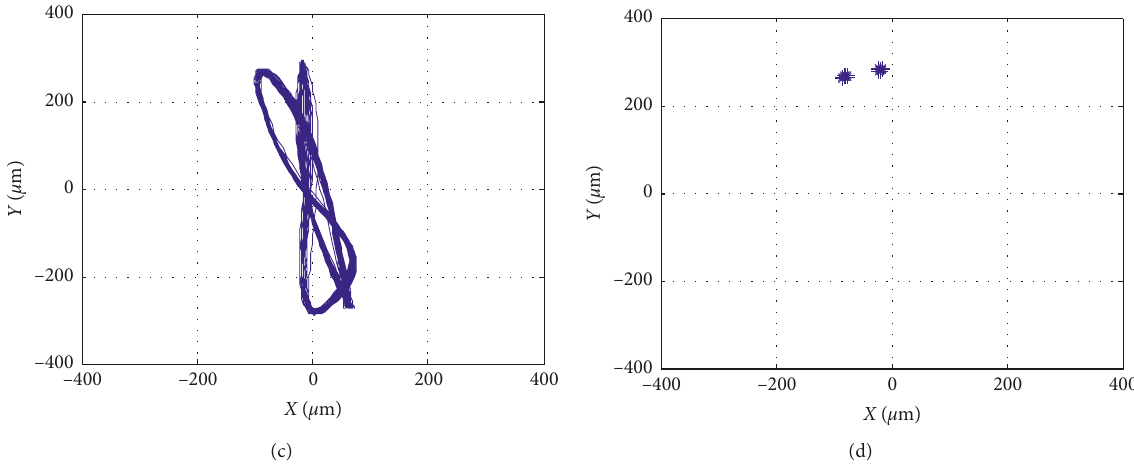
Figure 14: Severe rubbing at 3000r/min. (a) Time-domain waveform. (b) Spectrum graph. (c) Axis orbit. (d) Poincare orbit.